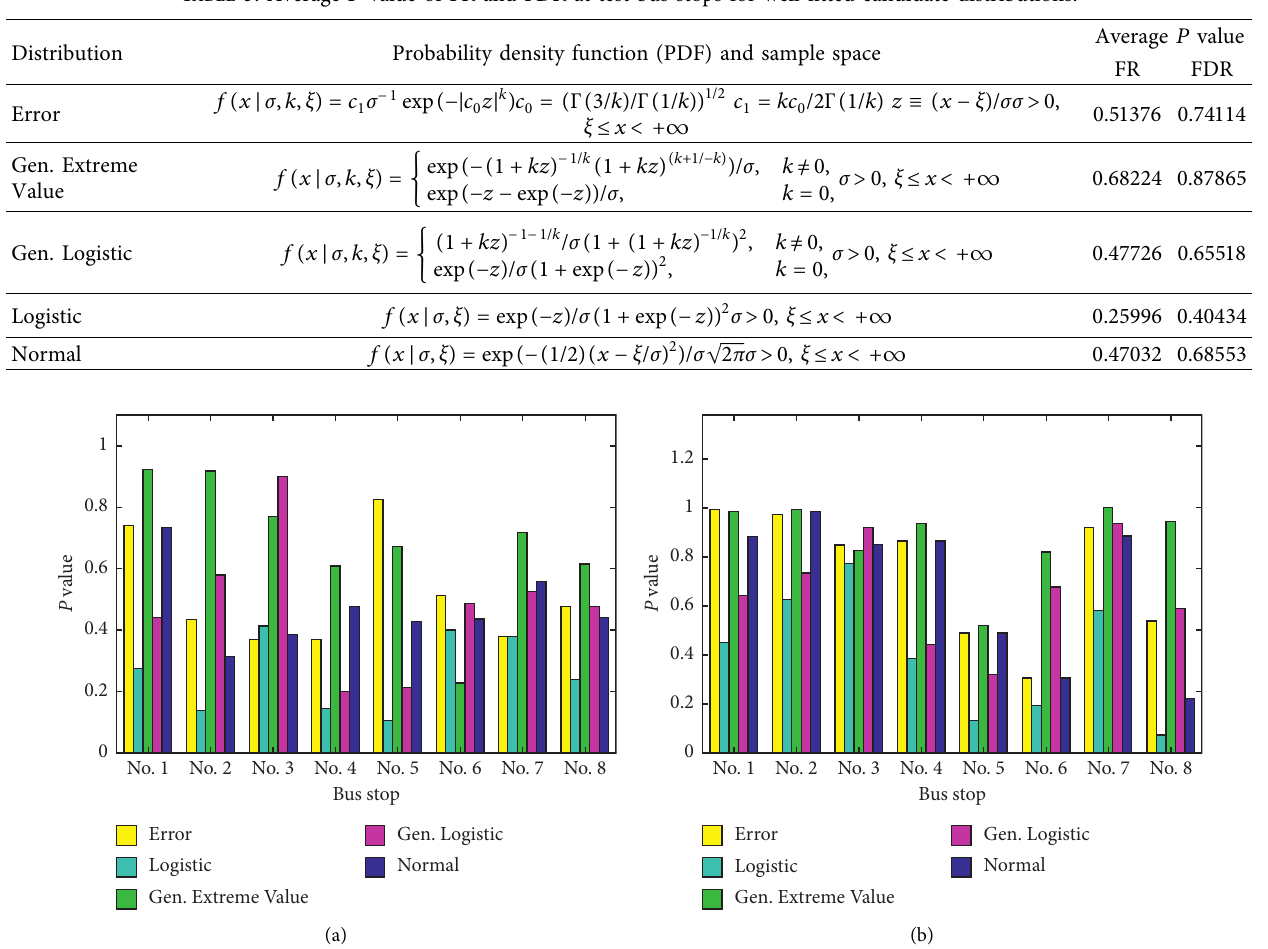
Figure 10: Well-fitted candidate distributions P value comparison for bus failed characteristics. (a) Failure rate (%). (b) Failure duration rate (%). Table 6: Parameters of fitted FR and FDR at test bus